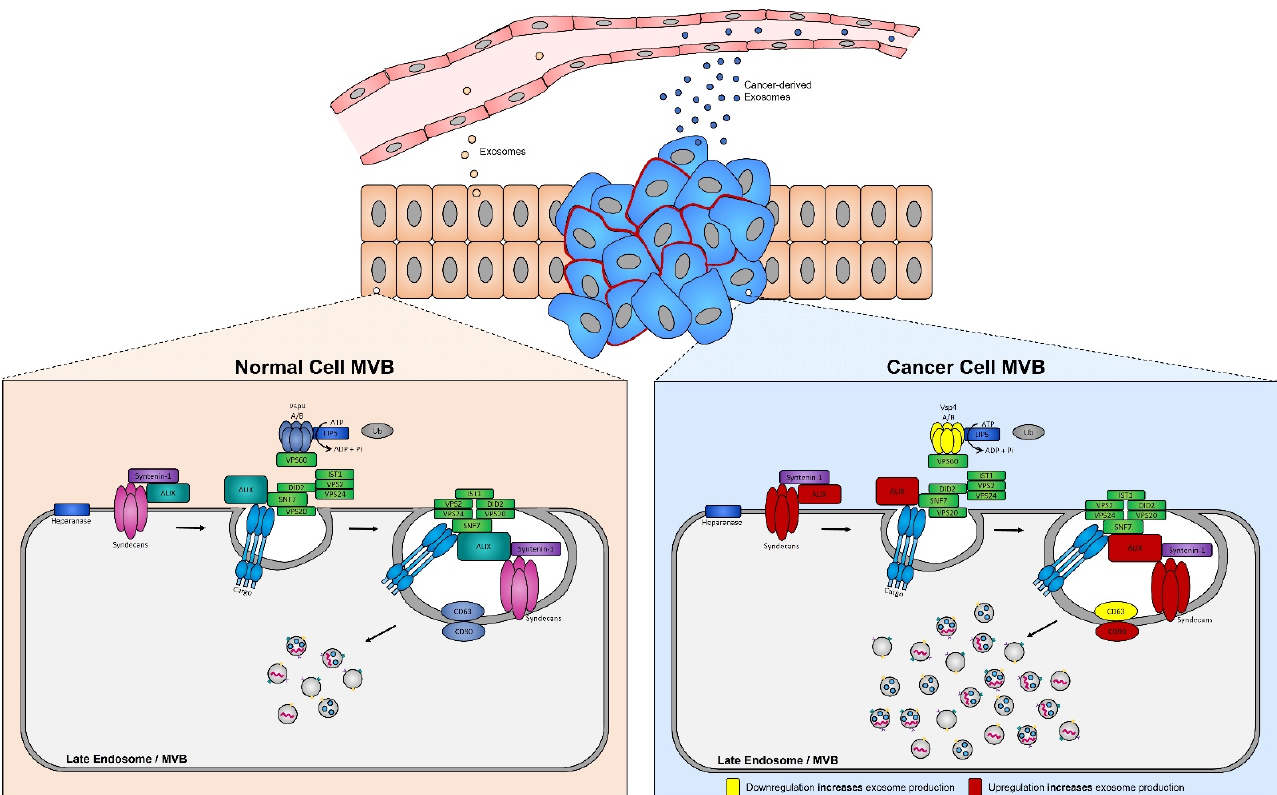
Figure 5. Syndecan–syntenin–ALIX couples to ESCRT-dependent MVB formation in healthy versus cancer cells. Syntenin-1 interacts directly with syndecans and ALIX, the interaction of ALIX with Snf7 of the ESCRT-III complex forms the syndecan–syntenin–ALIX pathway which is directly linked to exosome biogenesis. In cancer, several proteins in this pathway are altered, leading to enhanced exosome production. Alterations leading to the upregulation of either the syndecans, ALIX, and/or CD90 all result in enhanced exosome production, whereas any alterations leading to the downregulation of the ESCRT-III protein Vsp4 A/B and/or CD63 results in the increased production of exosomes seen in cancer cells.